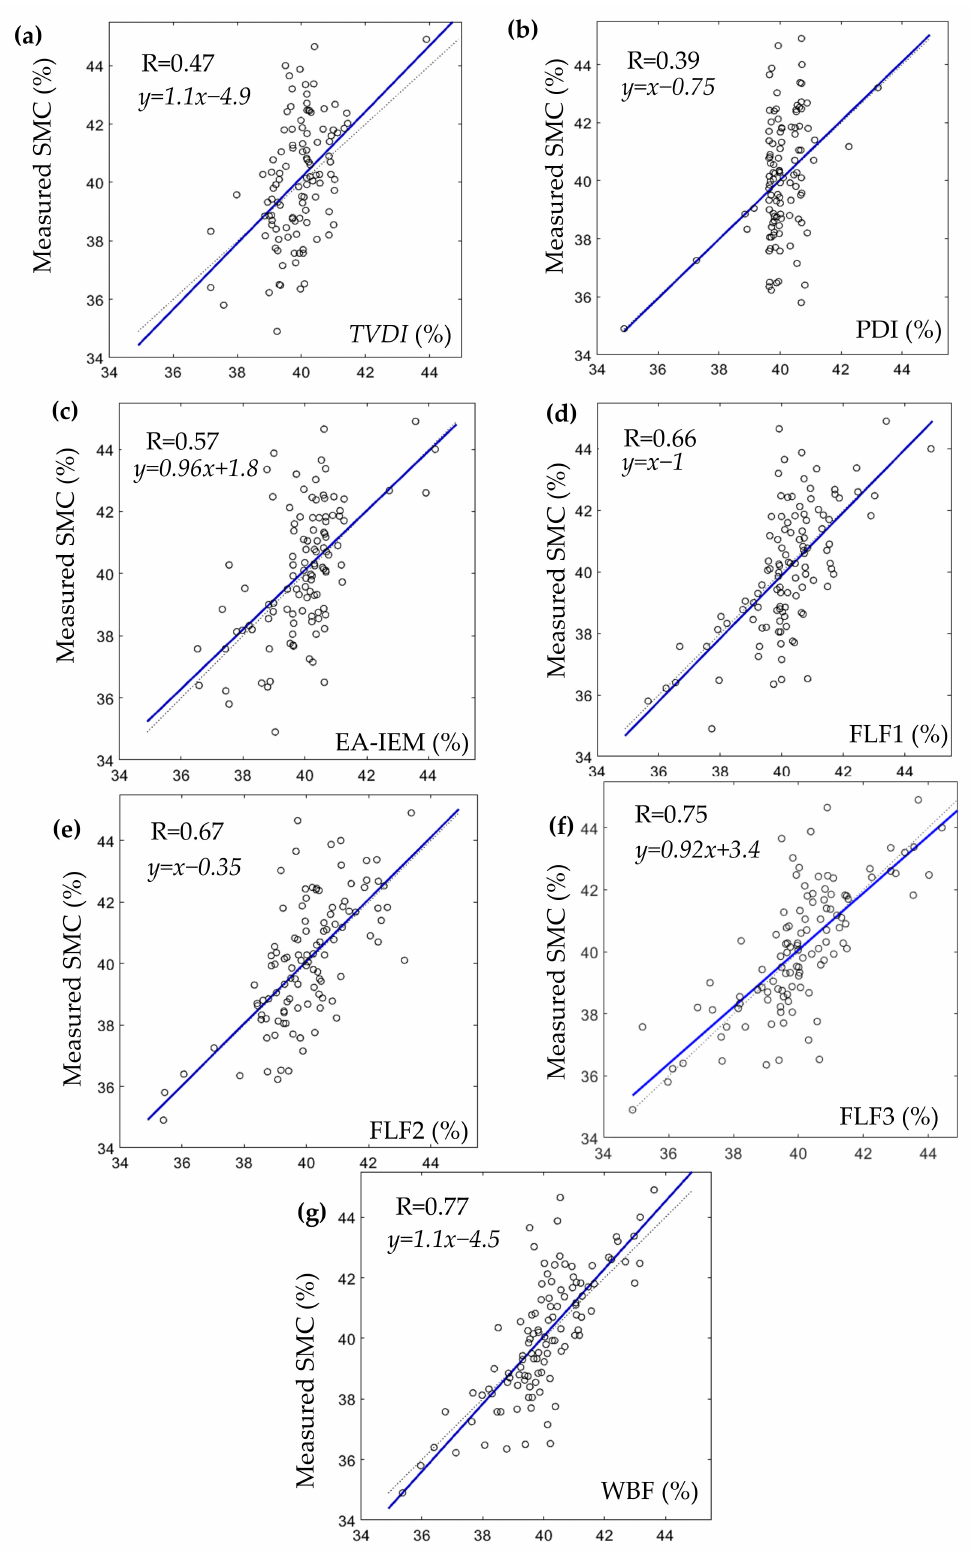
Figure 8. Results of each of the used SMC estimation methods in Blackwell farms datasets where: ( a ). TVDI. ( b ). PDI. ( c ). EA-IEM. ( d ). FLF1. ( e ). FLF2. ( f ). FLF3. ( g ).